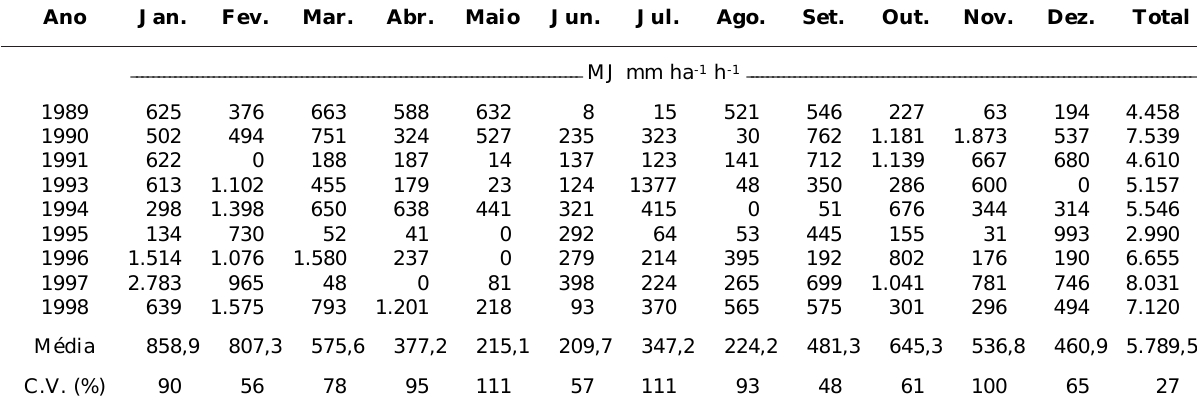
influencia a predição das perdas de solo pelo modelo